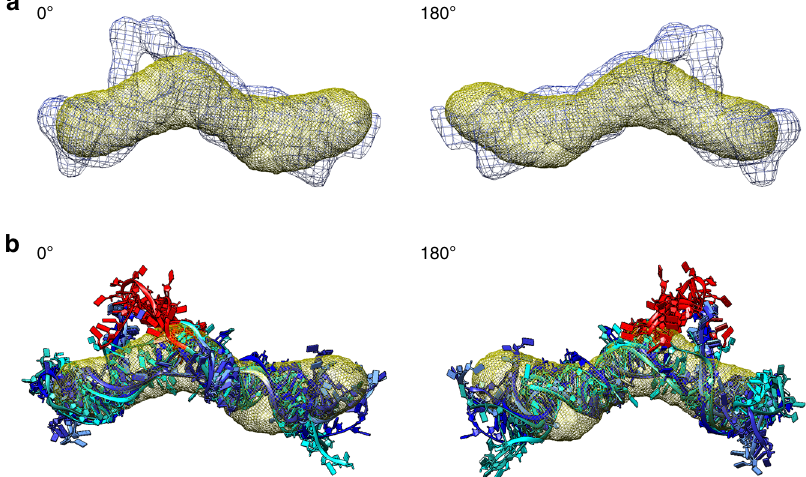
Fig. 6 Superposition of atomistic models of Bvht 5 ′ module with experimental structure (yellow mesh). a Ensemble of simulated structures of the fi ve top χ ranked atomistic models of Bvht 5 ′ module (blue mesh) superimposed with SAXS structure (yellow mesh). b Five top χ ranked atomistic models of Bvht 5 ′ module at 6 mM Mg 2 + (cyan to dark blue gradient). As in the full-length Bvht , atoms outside of SAXS-derived solution structure may indicate fl exible regions. Most of this “ fl exible ” region is the 11-nucleotide region (colored red) in the RHT/AGIL motif known to be essential to bind CNBP 3 . See Supplementary Movie 3 for more information.